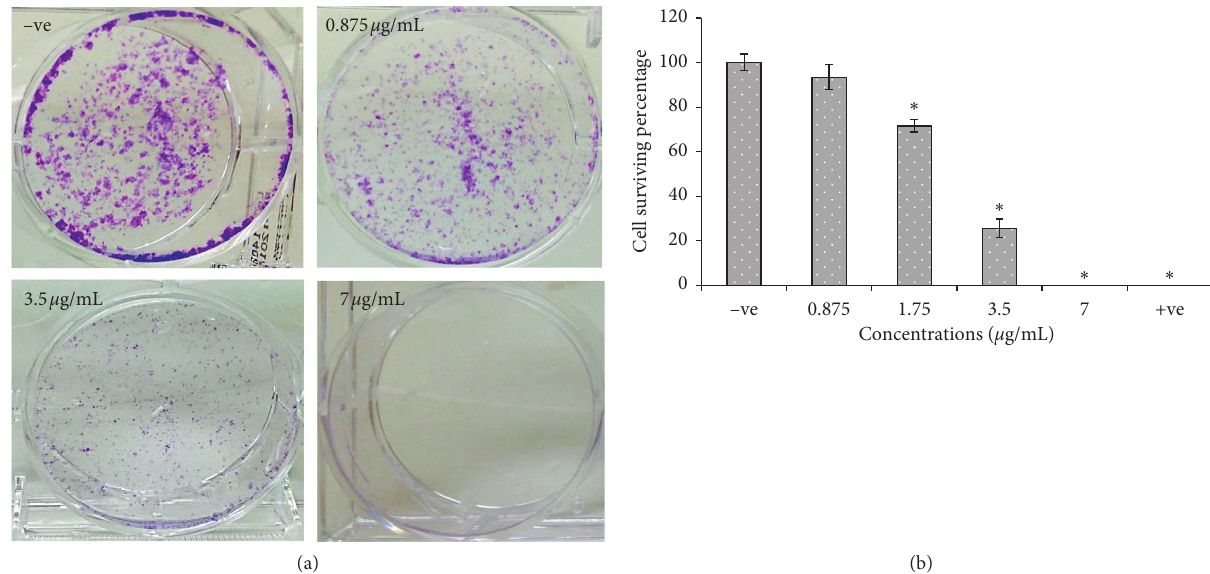
Figure 3: (a) MCF-7 cells in a colony formation assay. Cells were treated by ethanol ( − ve) or EHX at different concentrations. (b) Percentage of cell surviving in colony formation assay. Tamoxifen (10 μ g/mL) was used as a positive control (+ve). Values are mean ± SD. ∗ p < 0.05.